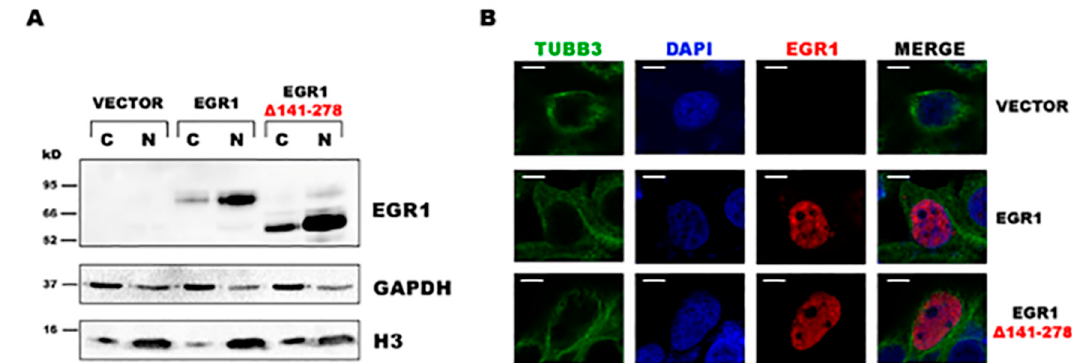
Figure 2. Cellular localization of EGR1 ∆ 141–278 splicing isoform. ( A ) Analysis of EGR1 localization by Western blotting. HEK293T cells transfected with both EGR1 constructs and an empty plasmid were subjected to cellular fractionation. Distribution of canonical and EGR1 ∆ 141–278 isoforms was analyzed in cytosolic (C) and nuclear (N) fractions. Glyceraldehyde-3-phosphate dehydrogenase